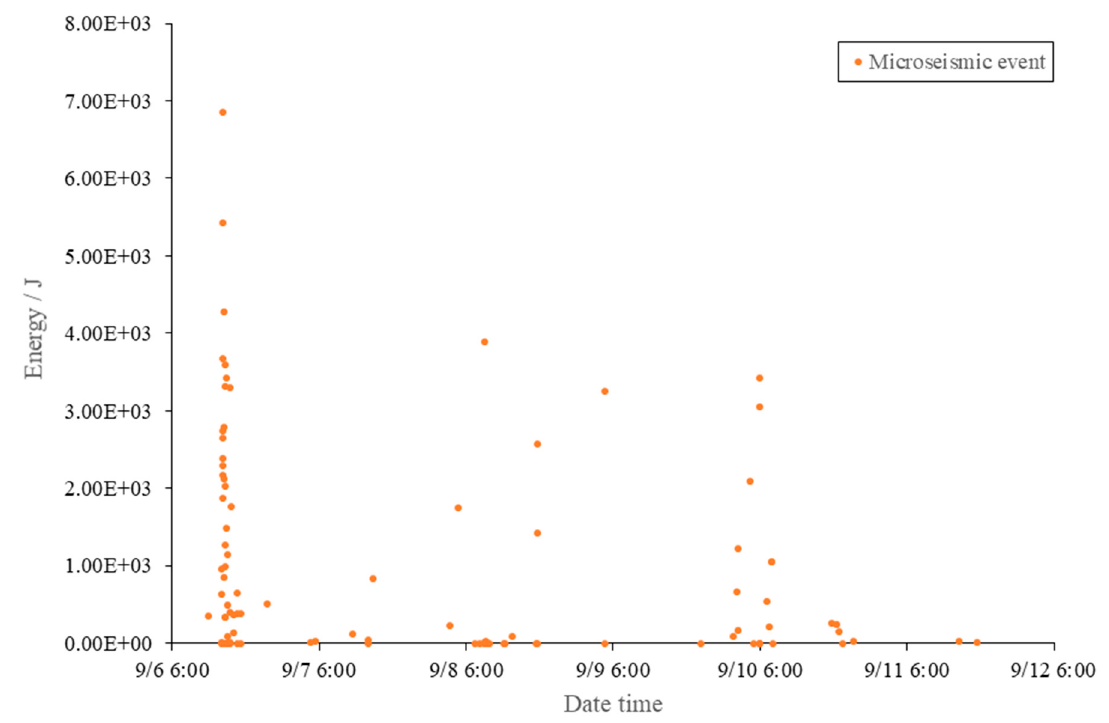
Figure 9. Microseismic events and energy characteristics during the measurement of stress relief boreholes.